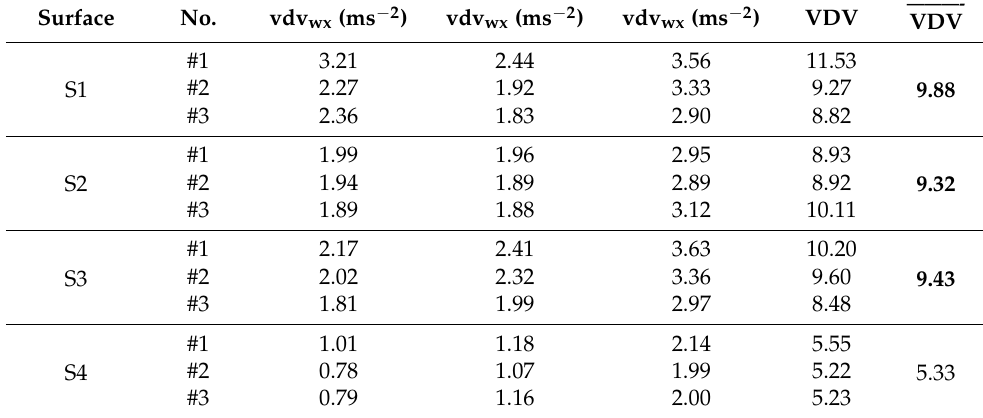
Table 6. Summary of data obtained from driver 1 according to ISO 2631-1:1997, method VDV. Surface